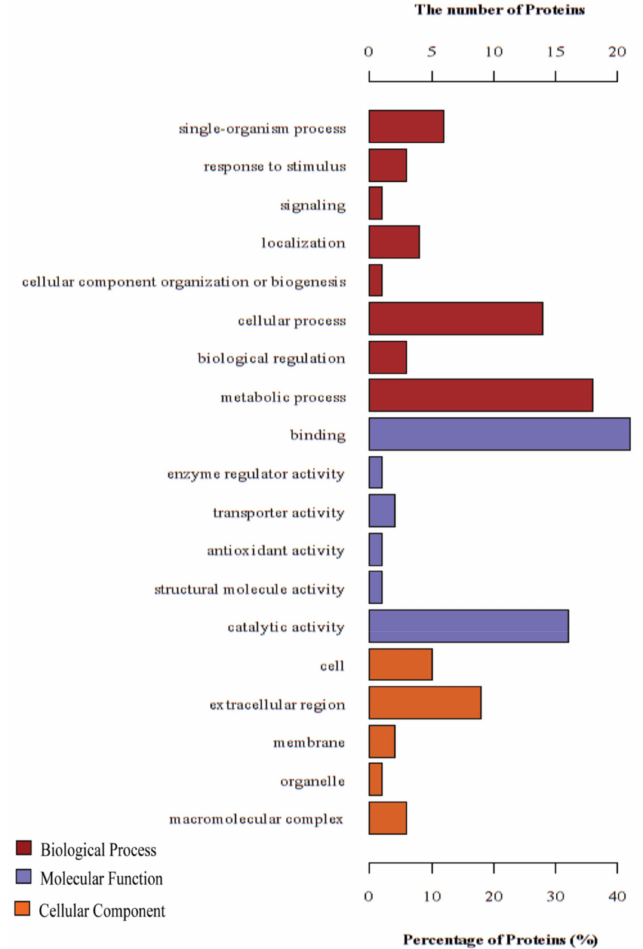
Figure 2. Distribution of the Gene Ontology (GO) terms for all proteins identified from the control and infected hemolymph: The DEPs were classified into cellular component, molecular function, and biological process by